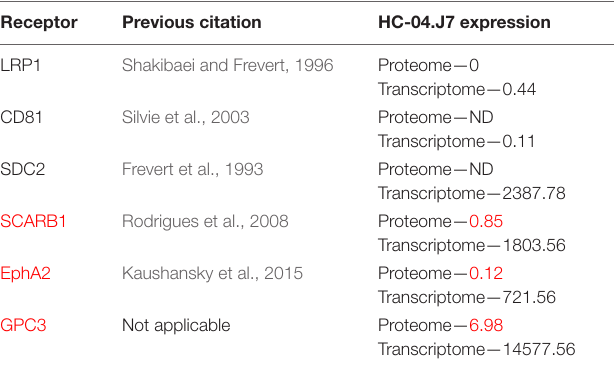
TABLE 4 | Previously identified hepatocyte surface receptors involved in sporozoite invasion and their expression in